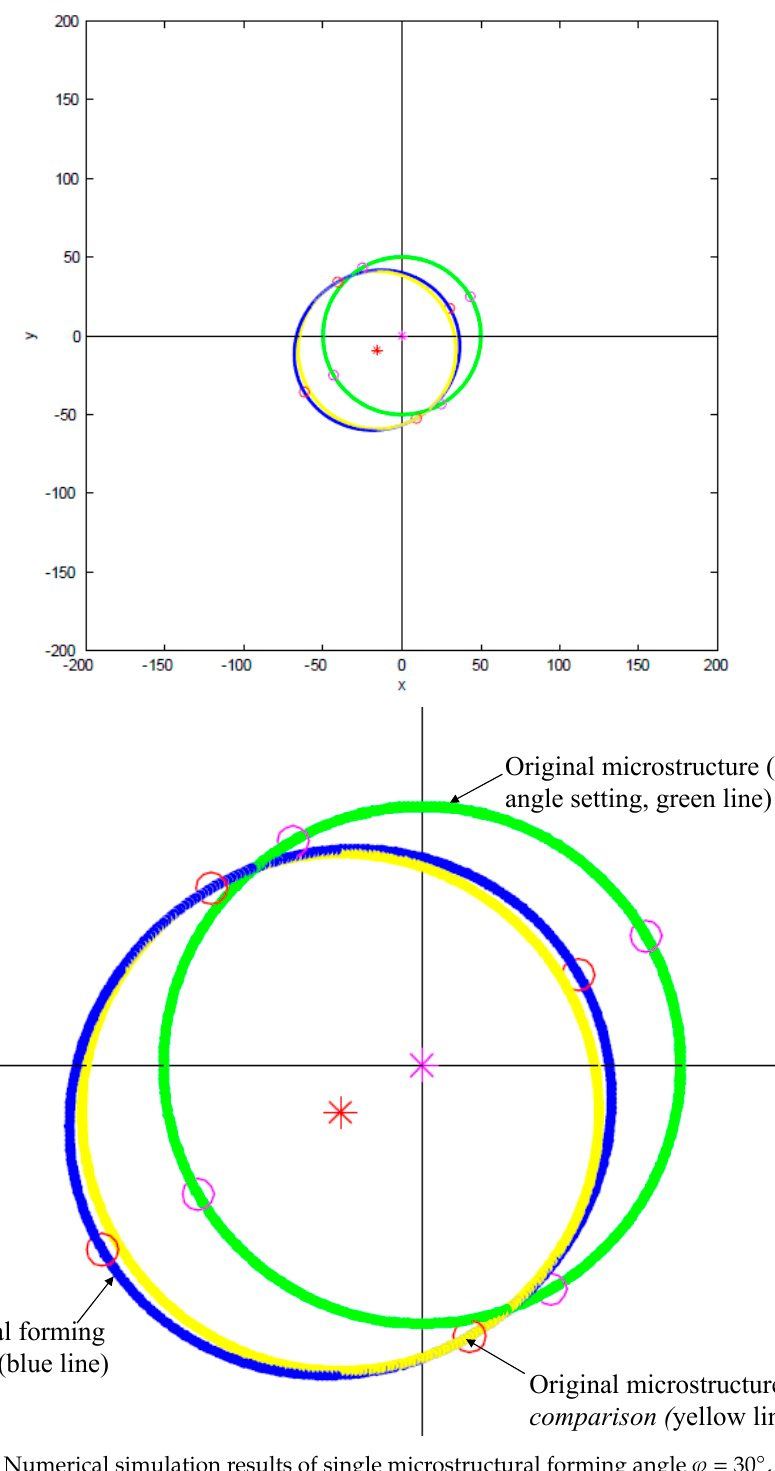
Figure 14. Numerical simulation results of single microstructural forming angle 𝜑 = 30°, 𝜃 = 20°.